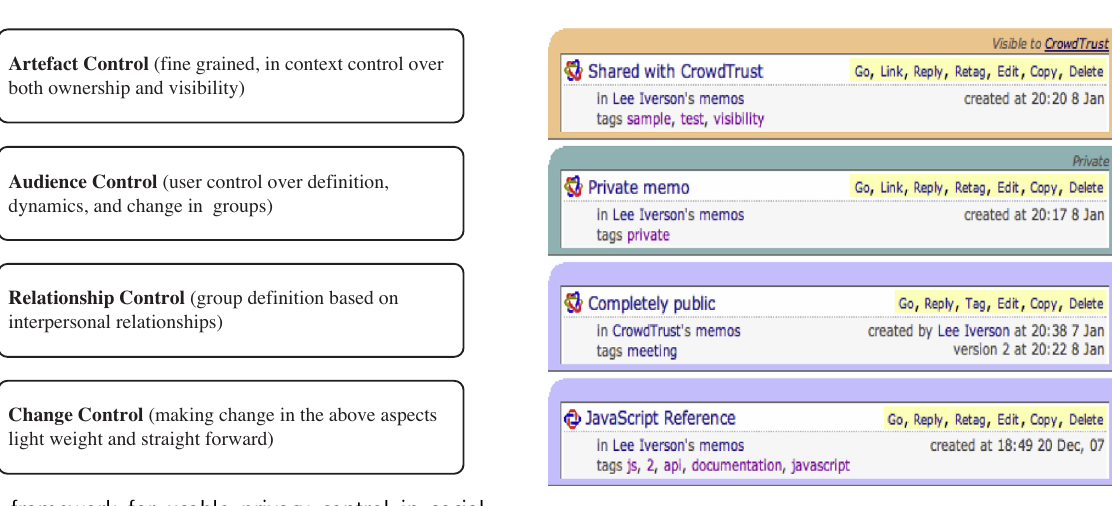
Figure 3. Memos in OpnTag: public, private, and selectively shared in a group.